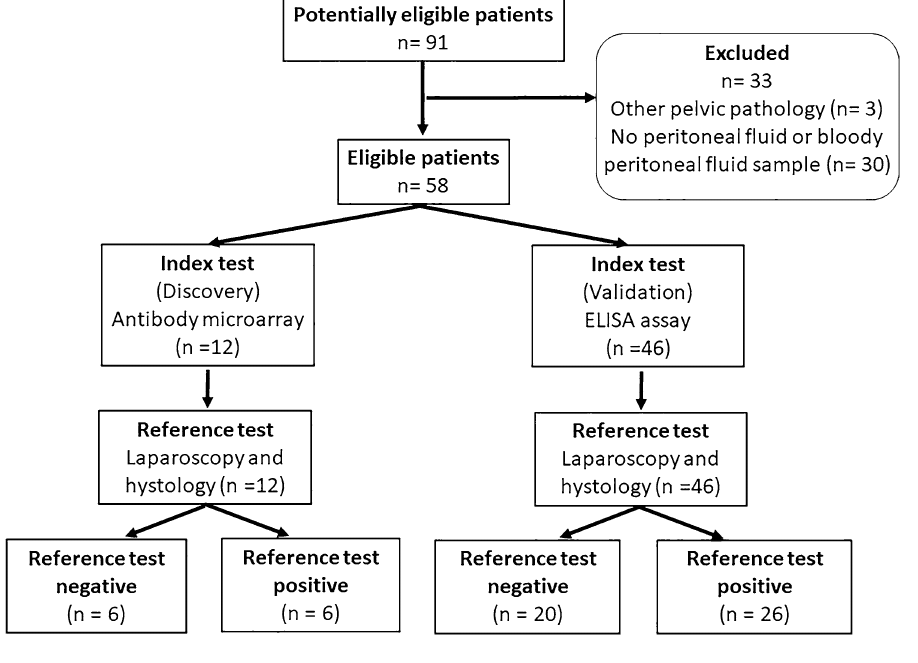
Figure 1. Flowchart of patient recruitment.